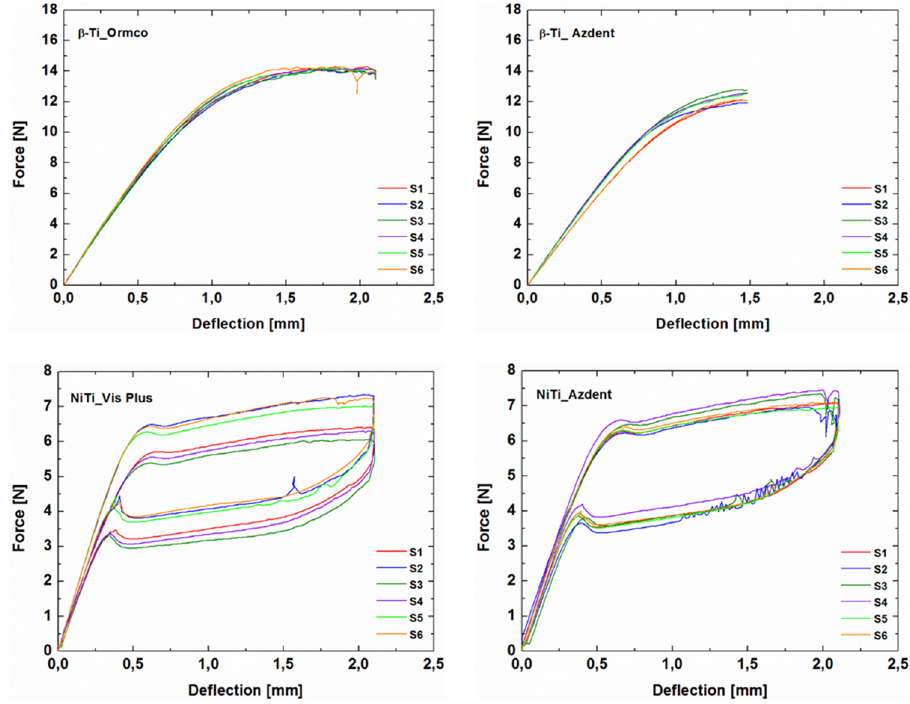
Figure 7. Three-point bending force-deflection plots of all specimens of each product. Specimen numbers are represented as S1–S6.